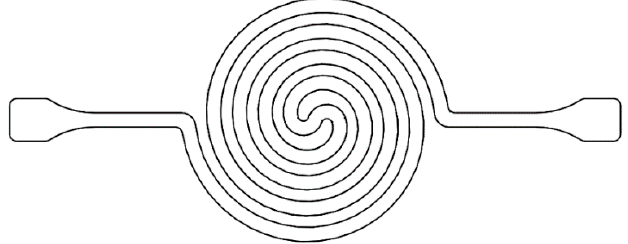
Figure A14. Fabric Design XLP-3. Large lengthwise pass design, woven conductive polyester fabric.